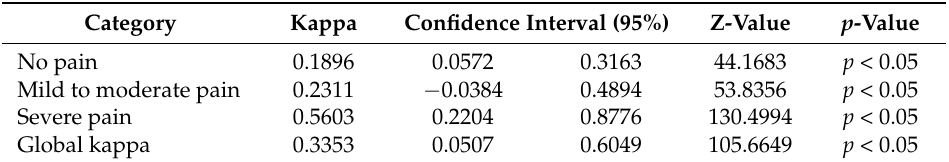
Table 5. Level of agreement among sheep farmers ( n = 125) in the recognition of pain associated with husbandry practices in lambs. Fleiss’ kappa coefficient values for pain categories: No pain (0), Mild to moderate pain (1–5), Severe pain (6–10), according to pain intensity scores used in a numerical rating